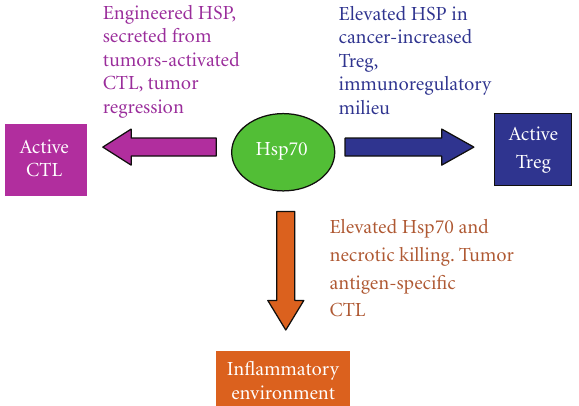
Figure 2: Contrasting immunological influences of HSPs under di ff ering contexts. We show that HSPs in cancer cells can inhibit or promote tumor immunity, depending on the tissue context. Tumor HSP levels become elevated during progression (blue